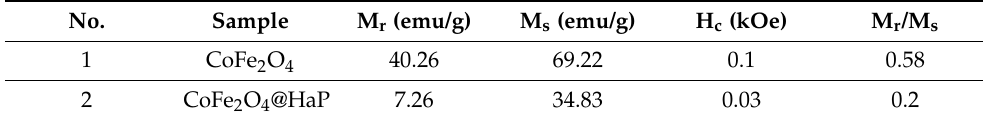
Figure 6. Magnetization of CoFe 2 O 4 @HaP sample. Table 3. Magnetic parameters for CoFe 2 O 4 and CoFe 2 O 4 @HaP samples .